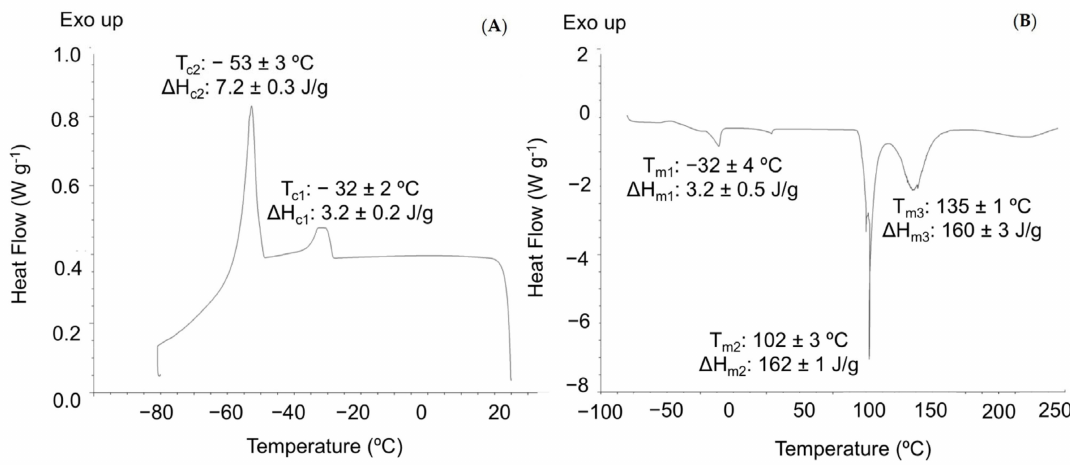
Figure 3. Di ff erential scanning calorimetry (DSC) curves and parameters obtained for crystallization ( A ) and melting ( B )